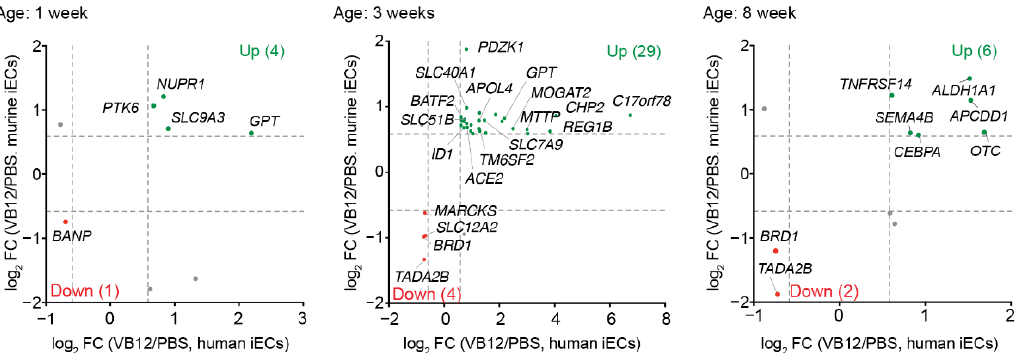
Figure 2. Comparison of human and mouse iEC-enriched genes. Green dots indicate genes upregulated in both human iECs cultured with VB12 and iECs isolated from VB12-gavaged mice of different ages (1, 5, and 8 weeks old), compared to their PBS counterparts. Red dots indicate genes downregulated in the VB12 group of both human and mouse iECs. Dashed lines indicate fold changes of 1.5. log 2 FC, log 2 (fold change).